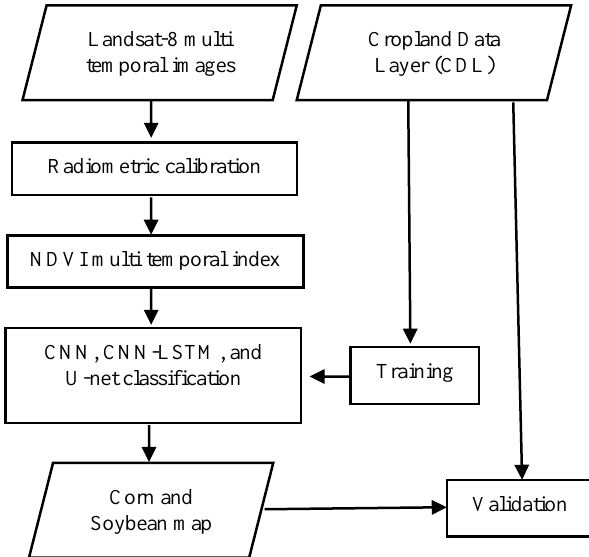
Figure 4. Flowchart of the proposed